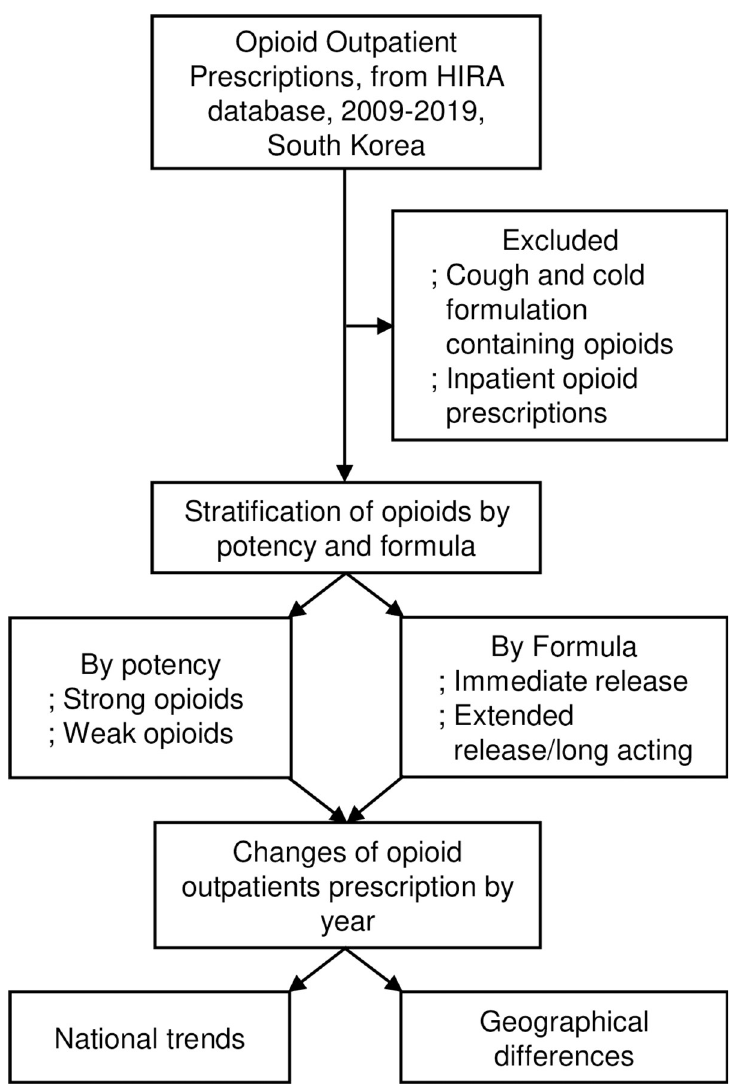
Fig 1. Flow chart of study design. Abbreviation: HIRA, Health Insurance Review and